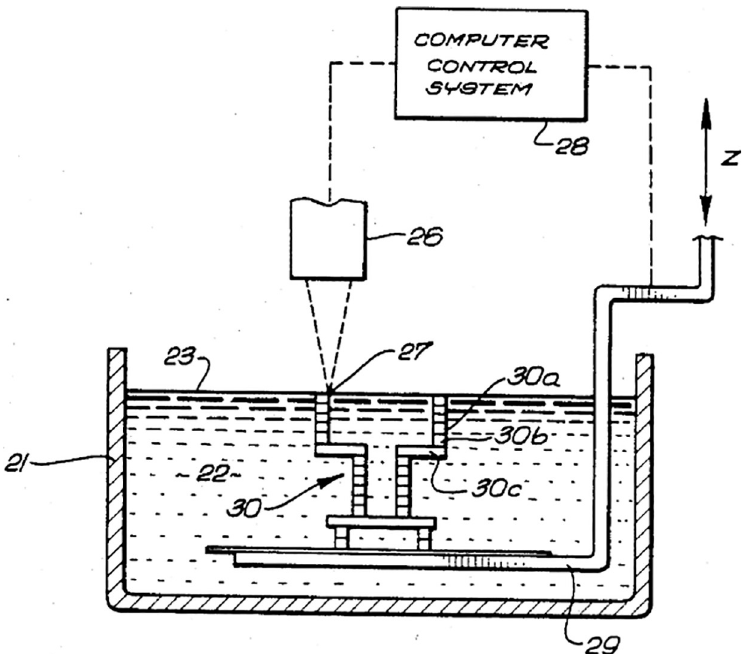
Fig 2. Sketch corresponding to the first VAT photopolymerization machine. Original sketch of the “apparatus for production of three-dimensional objects by stereolithography”, extracted from the US patent US4575330A.